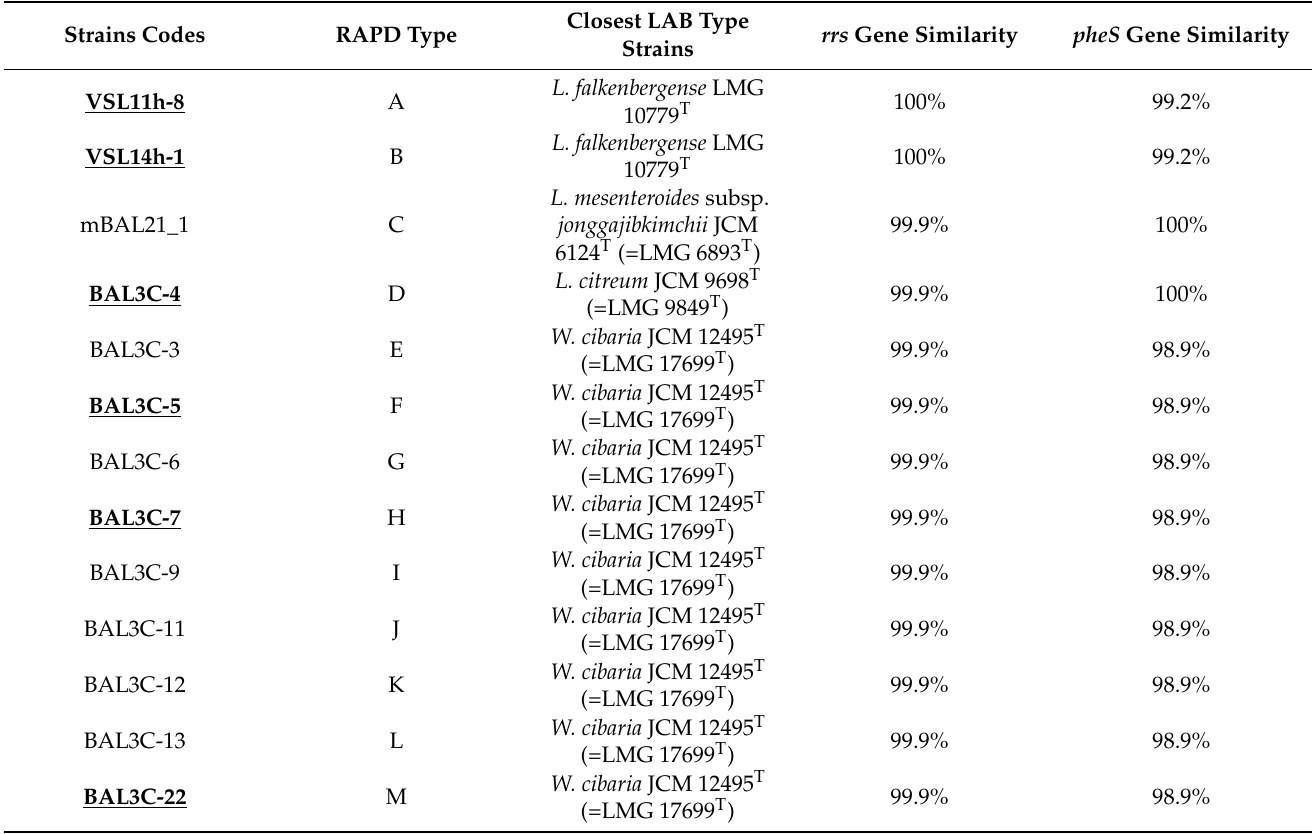
Table 1. Summary of the complete species identification of 13 lactic acid bacteria (LAB) representative strains. Strains